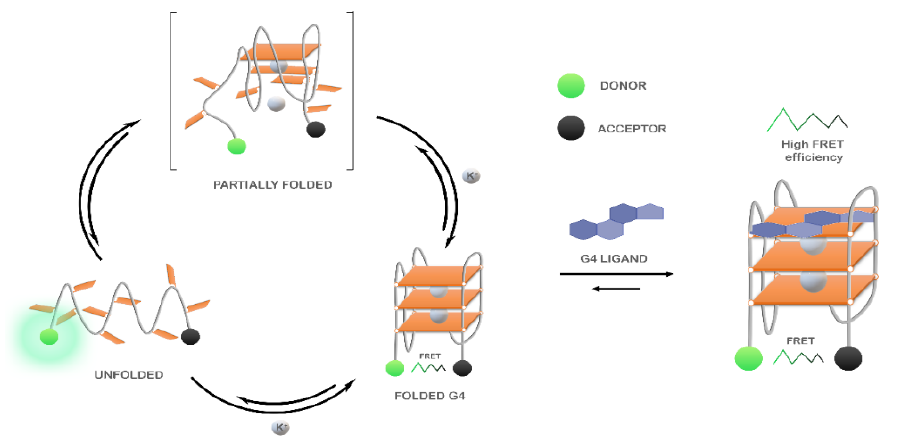
Figure 20. Schematic general representation of FRET-melting experiments.